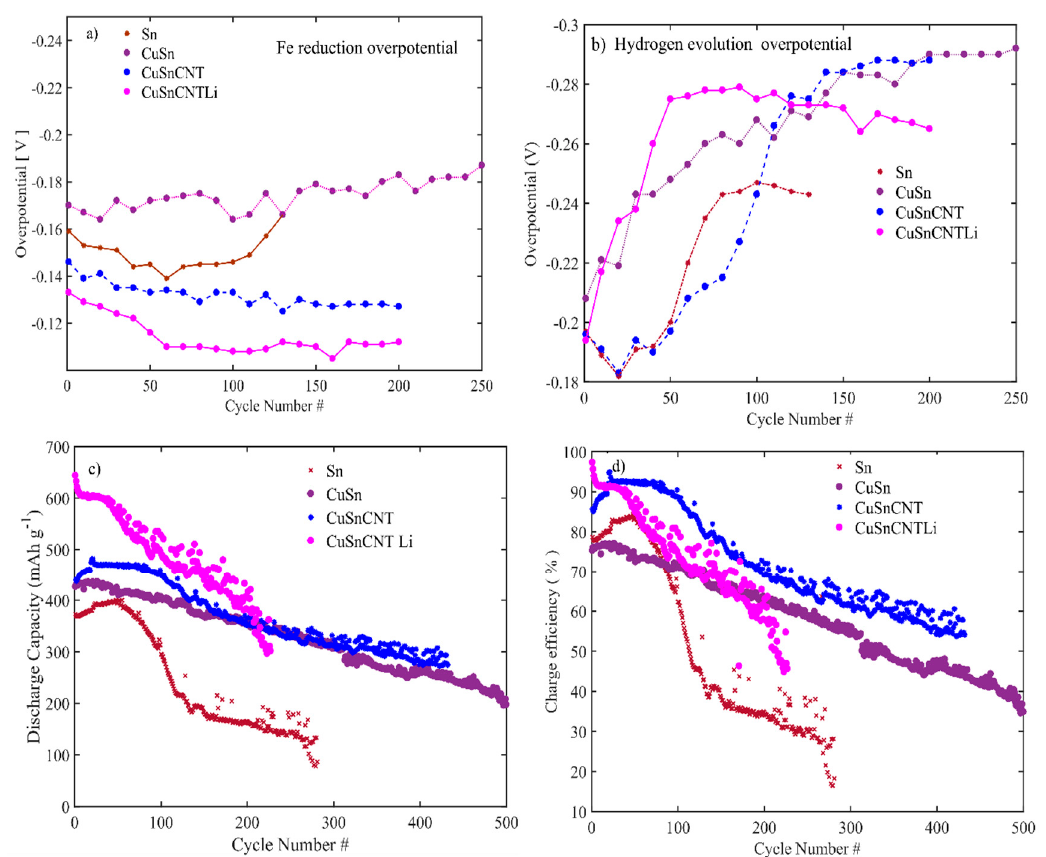
Figure 7. Change in overpotential over cycles ( a ) Fe reduction overpotential (first plateau); ( b ) hydrogen evolution overpotential (second plateau); ( c ) Specific discharge capacity and ( d ) Charge efficiency of electrodes vs. cycle number.